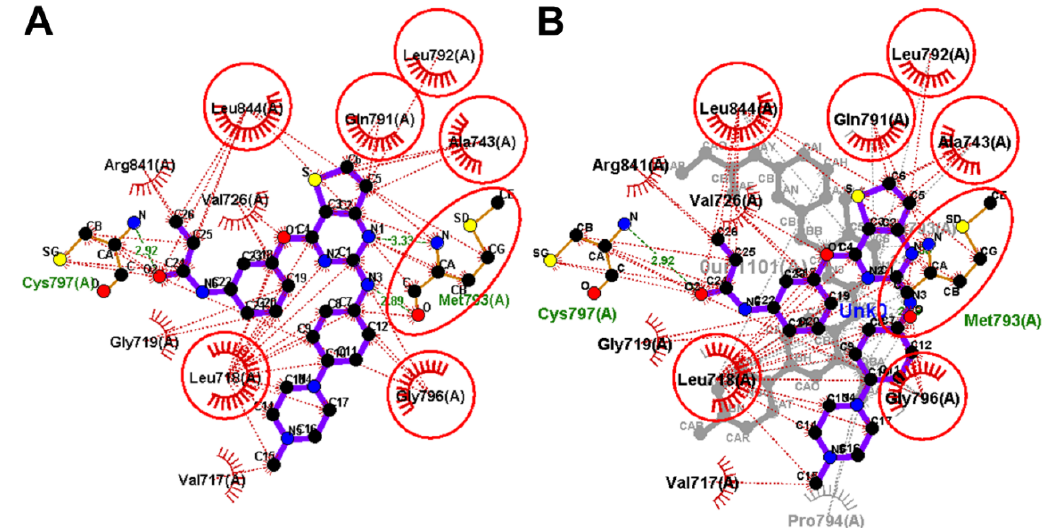
Figure 18. Binding interactions of olmutinib (shown as purple sticks) into EGFR T790M (pdb: 5X2K): ( A ) the docked olmutinib; ( B ) superposed LigPlot view of olmutinib and the co-crystallized WZ4003 (gray sticks), the red circles/ellipses show the equivalent binding interactions, hydrogen bonds are shown in olive green dotted lines, and the hydrophobic interactions are shown in brick red dotted lines.